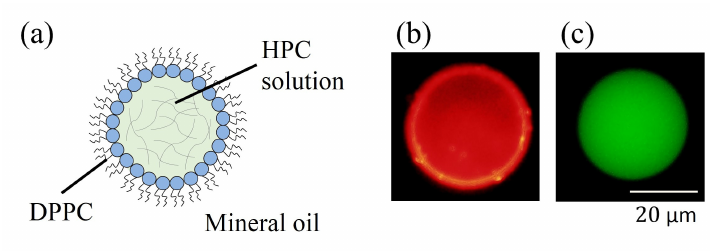
Figure 2. ( a ) Schematic illustration of HPC solution droplet (W/O type dorplet); ( b ) Microscopic images in the case of observation of dyes rhodamine DHPE, λ em = 580 nm (red), corresponding to place of lipids; ( c ) Microscopic images in the case of observation of dyes calcein, λ em = 515 nm (green), corresponding to place of water molecules inside the droplet, and in this photograph, the water molecules (also the HPC) are uniformly dispersed.